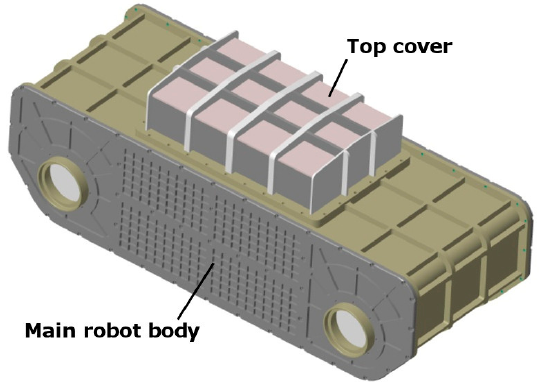
Figure 7. Main robot body with the top cover.